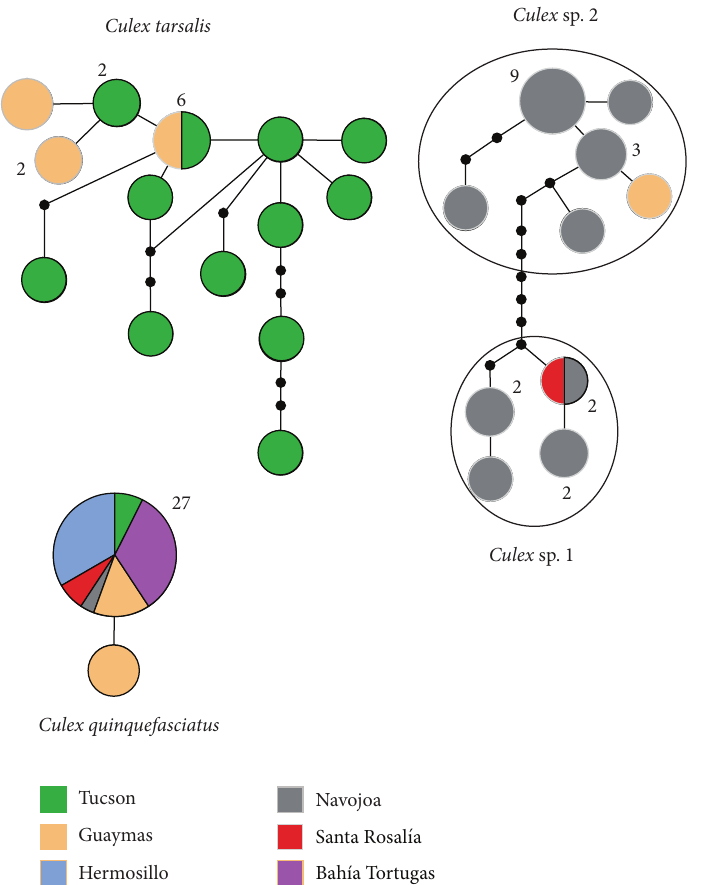
Figure 3: TCS haplotype network for the COI gene segment in Culex tarsalis ( 𝑁 = 23 ; see Table 1), Cx . quinquefasciatus ( 𝑁 = 28 ), Culex sp. 1 ( 𝑁 = 7 ), and Culex sp. 2 ( 𝑁 = 16 ) based on a 95% connection limit. Each line segment represents a single mutation. Inferred intermediate haplotypes that were not sampled are shown as small black dots on the line segments. Size of the circles is proportional to haplotype frequency. Numbers next to the circles represent number of individuals with that haplotype, if greater than one. Geographical localities are